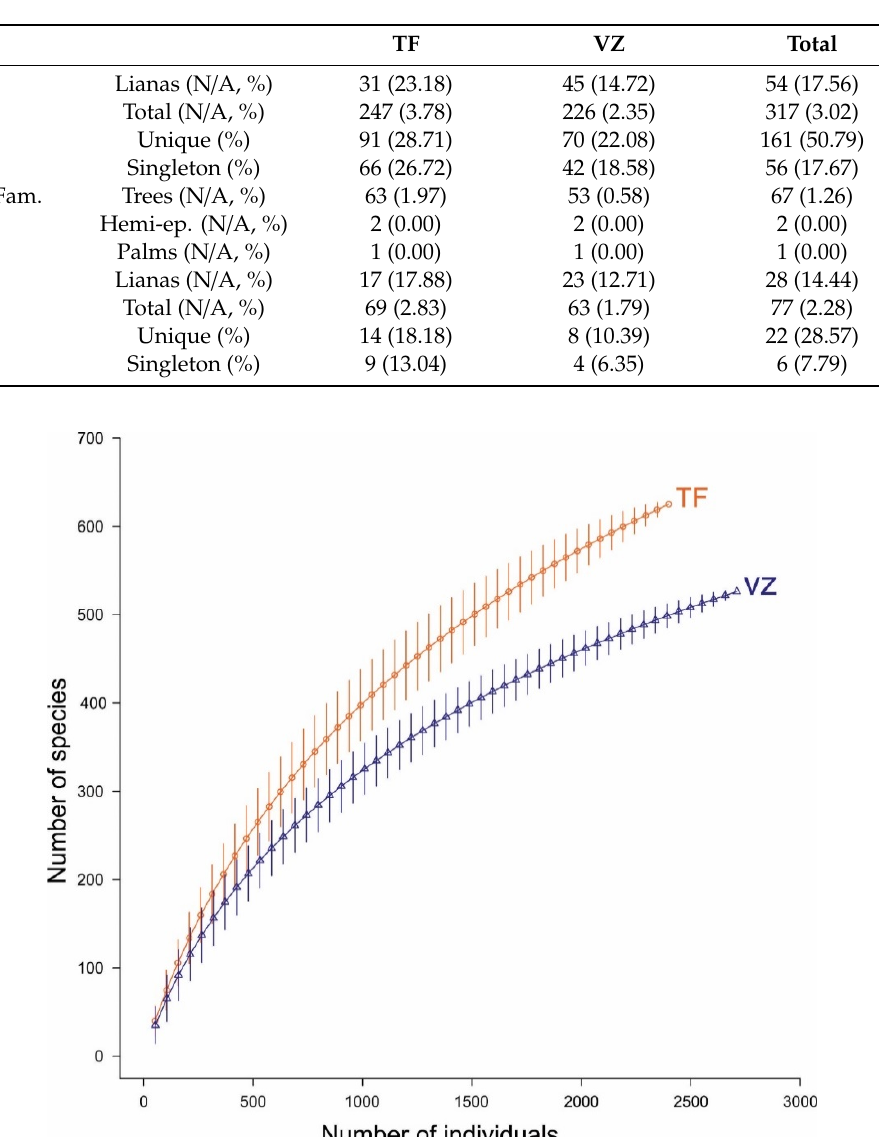
Figure 3. Sample-based rarefaction curves, scaled by the number of pooled individuals per survey plot (sample) for terra firme forest (TF, in orange) and várzea forest (VZ, in blue). The bars indicate ±2 standard deviations.